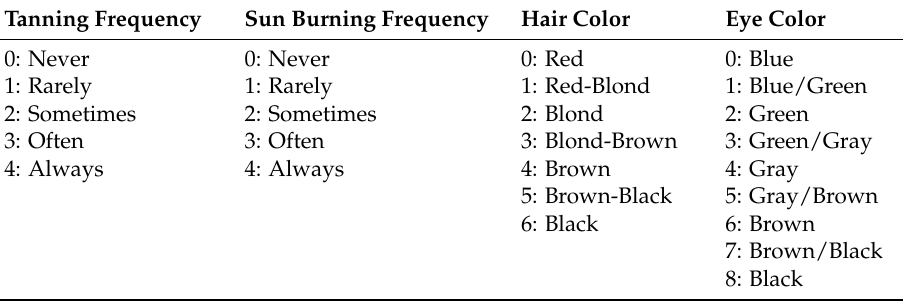
Table 2. Discrete rating scales for the input